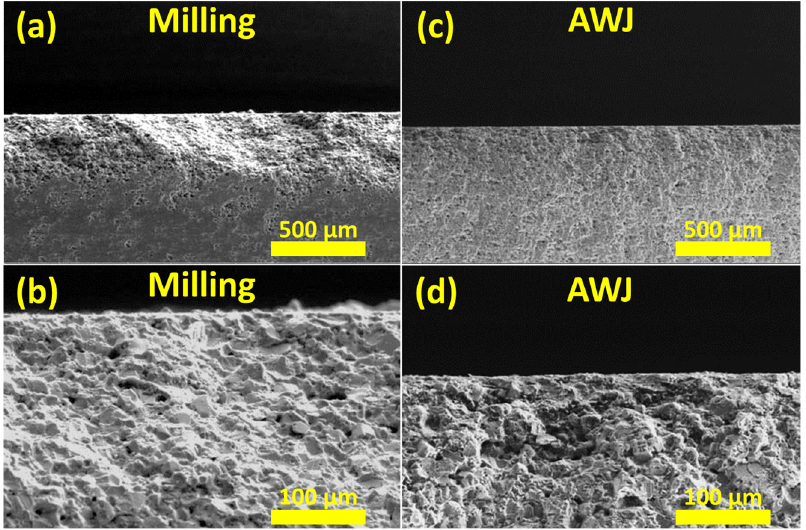
Figure 7. The edge machining difference in SE imaging mode of ( a ) conventional milling and ( b ) at higher magnification of depression area, and ( c ) optimal abrasive waterjet (AWJ) cutting at v = 160 mm/min, and ( d ) smooth AWJ cross-section magnified to 1000×.